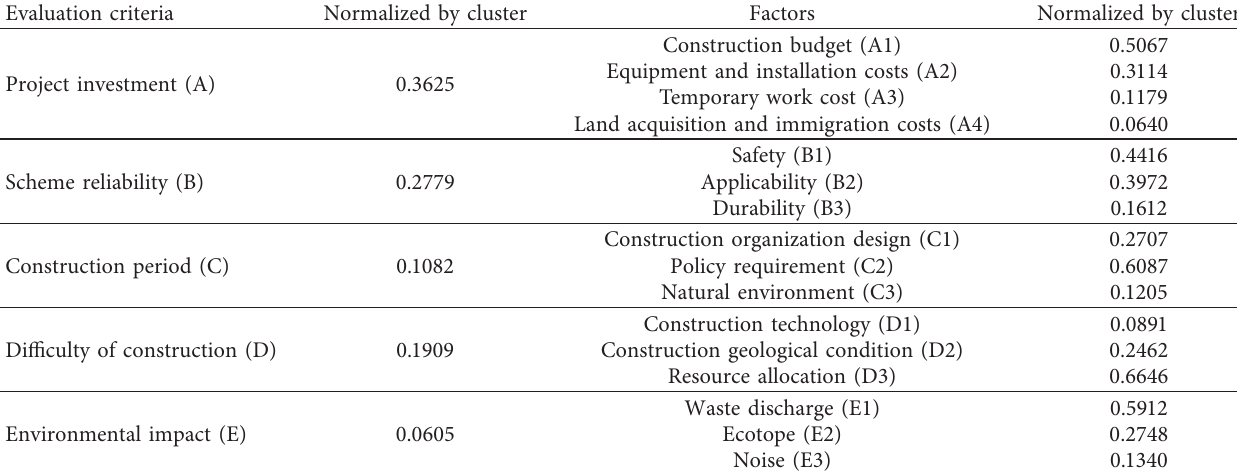
Table 1: Weights of scheme evaluation